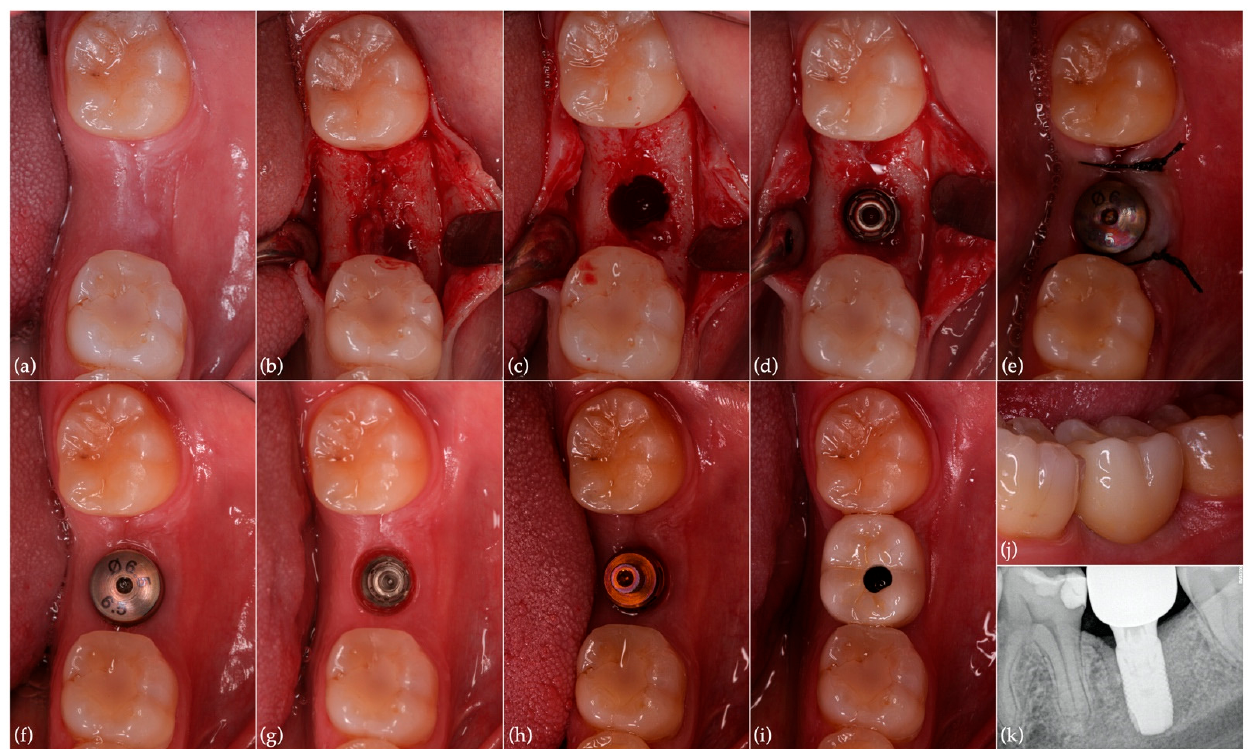
Figure 4. Implant surgery, prosthetic rehabilitation and last postoperative control: ( a ) clinical aspect 6 months after tooth extraction with alveolar preservation; ( b ) elevation of mucoperiosteal flap; ( c ) implant site preparation; ( d ) implant in place (OsseoSpeed TM EV 5.4 S–11 mm); ( e ) healing abutment in position and suture; ( f ) three months after surgery; ( g ) implant-soft tissue interface; ( h ) implant pick-up; ( i , j ) screw-retained implant zirconia crown in place; ( k ) periapical radiograph of the region of interest 1 year after implant surgery.